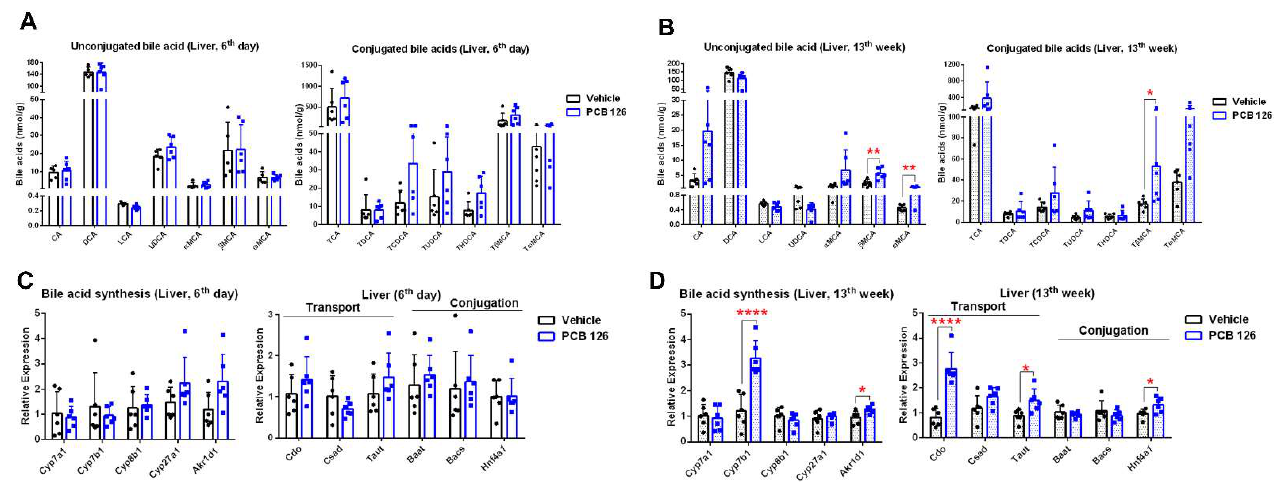
Figure 4. Effects of early life PCB 126 exposure on liver bile acid metabolism. ( A , B ) Quantitative UHPLC-MS/MS analysis of bile acids in the liver from mice with vehicle or PCB 126 exposure. ( C , D ) qPCR analysis of mRNA encoding bile acid biosynthesis, transport, and conjugation in the liver from mice with vehicle or PCB 126 exposure. Values are means ± S.D. ( n = 6 per group). * p < 0.05, ** p < 0.01, **** p < 0.0001 compared to vehicle. CA, cholic acid; DCA, deoxycholic acid; LCA, lithocholic acid; UDCA, ursodeoxycholic acid; MCA, muricholic acid; T, taurine-conjugated.